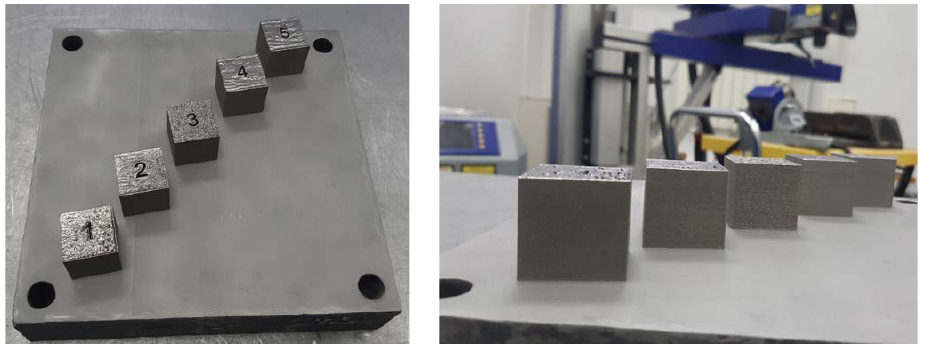
Figure 7. Grown samples on the build platform. Table 5. The experiment plan 2 2 ×3.